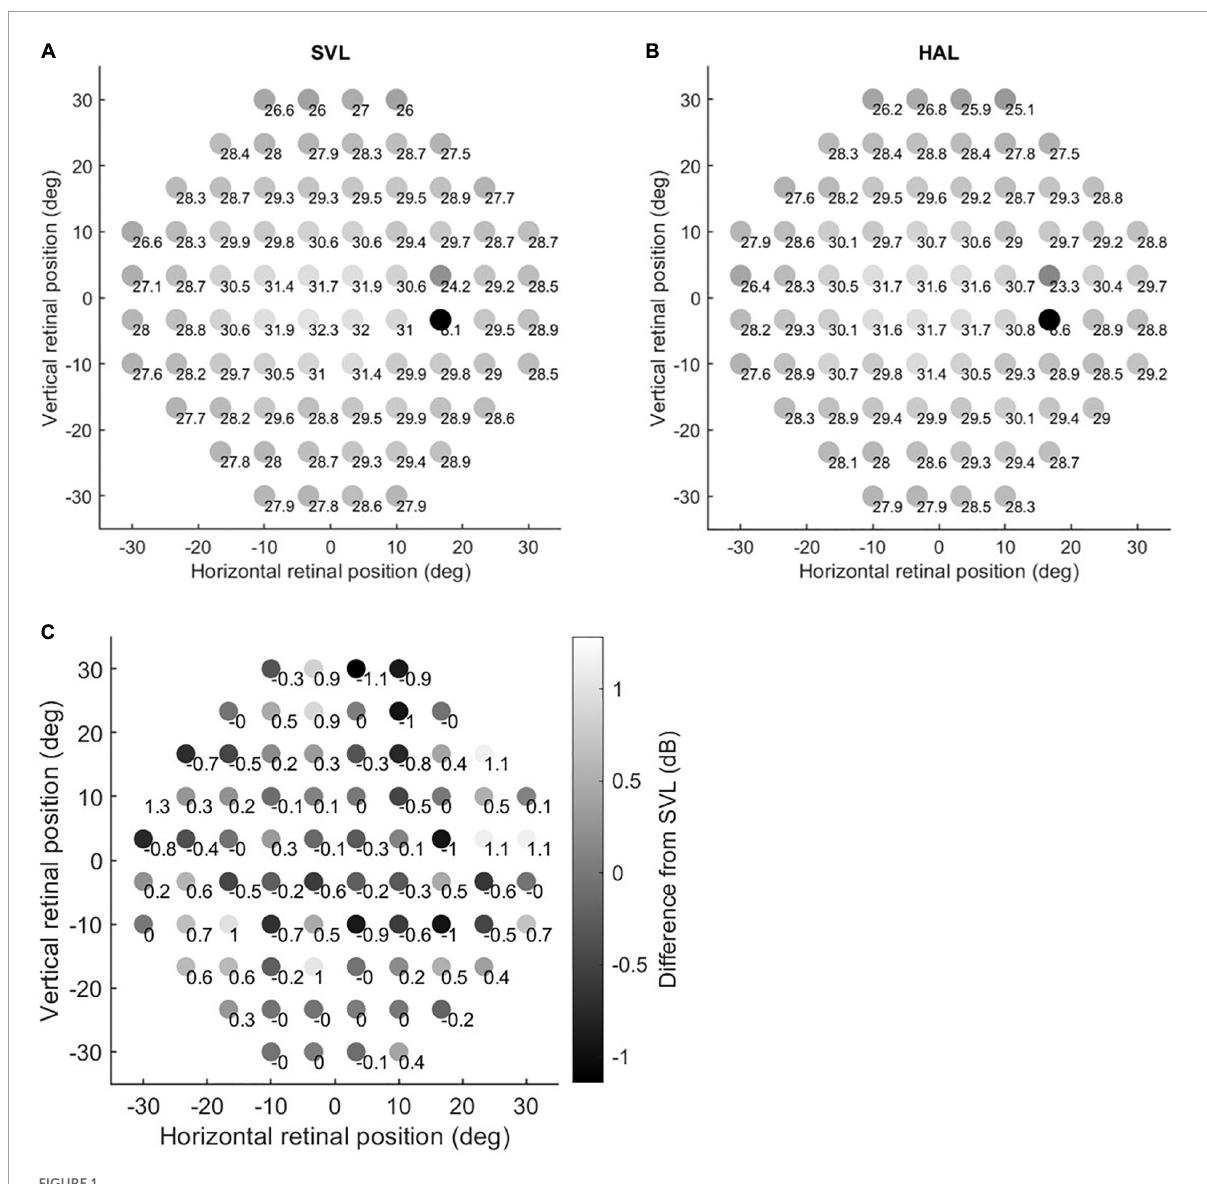
FIGURE1 Sensitivity maps. Panels (A,B) show the raw sensitivity data through the single vision lens (SVL) and the highly aspherical lenslets (HAL), respectively. The grayscale is proportional to the mean values. Panel (C) shows the mean difference between values in Panels (B,A) . Accordingly, positive numbers indicate increased sensitivity through the HAL and negative numbers indicate decreased sensitivity through the HAL compared to the